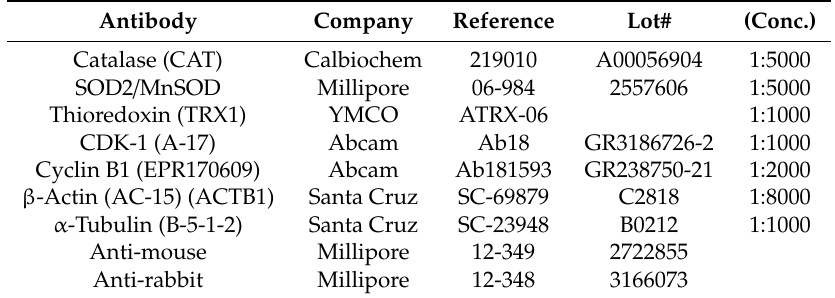
Table 1. Anti-human antibodies employed for Western blot (WB), immunocytochemistry (ICC) and immunohistochemistry